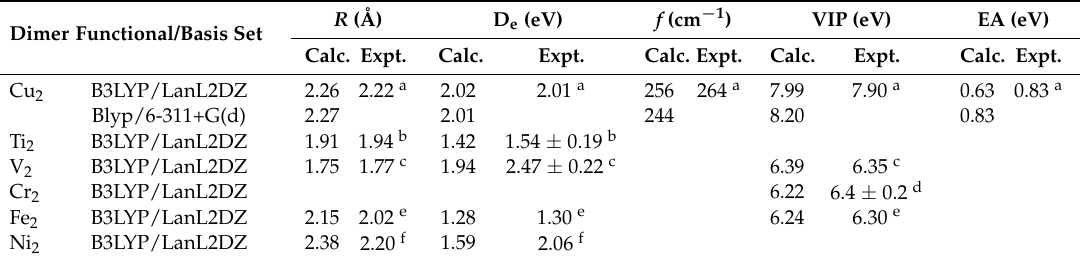
Table 1. The geometries and electronic properties of Cu 2 , Ti 2 , V 2 , Cr 2 and Fe 2 dimers. Dimer Functional/Basis